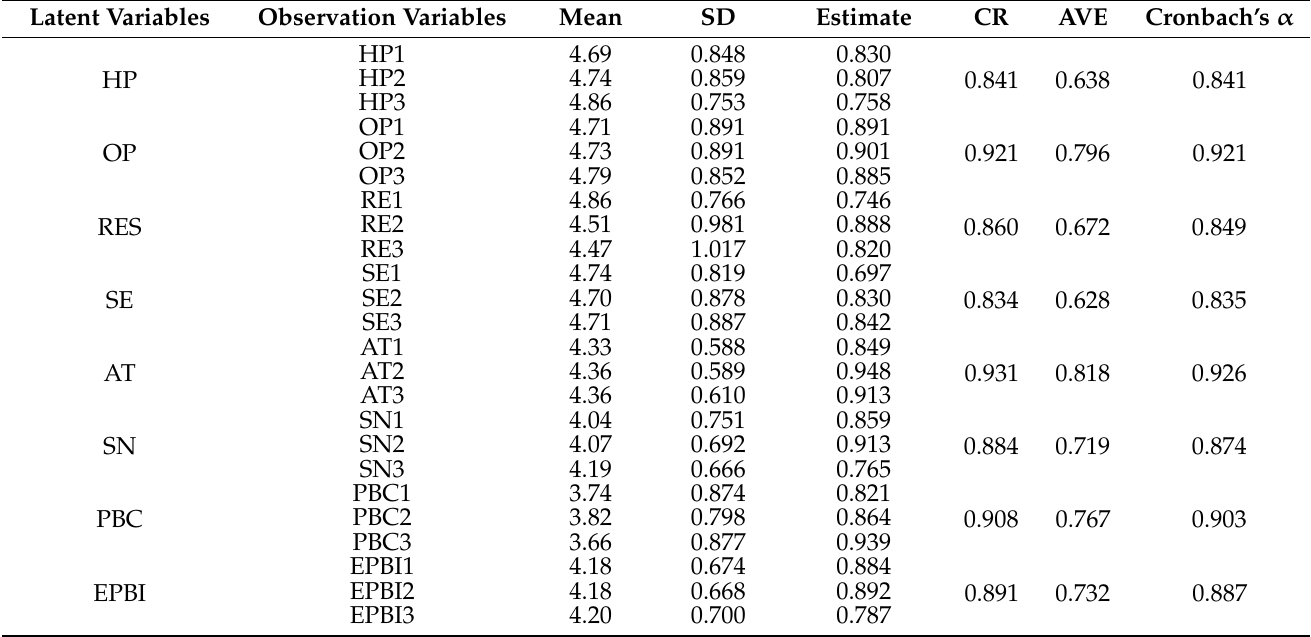
Table 3. Analysis of reliability, content validity, and convergent validity of the